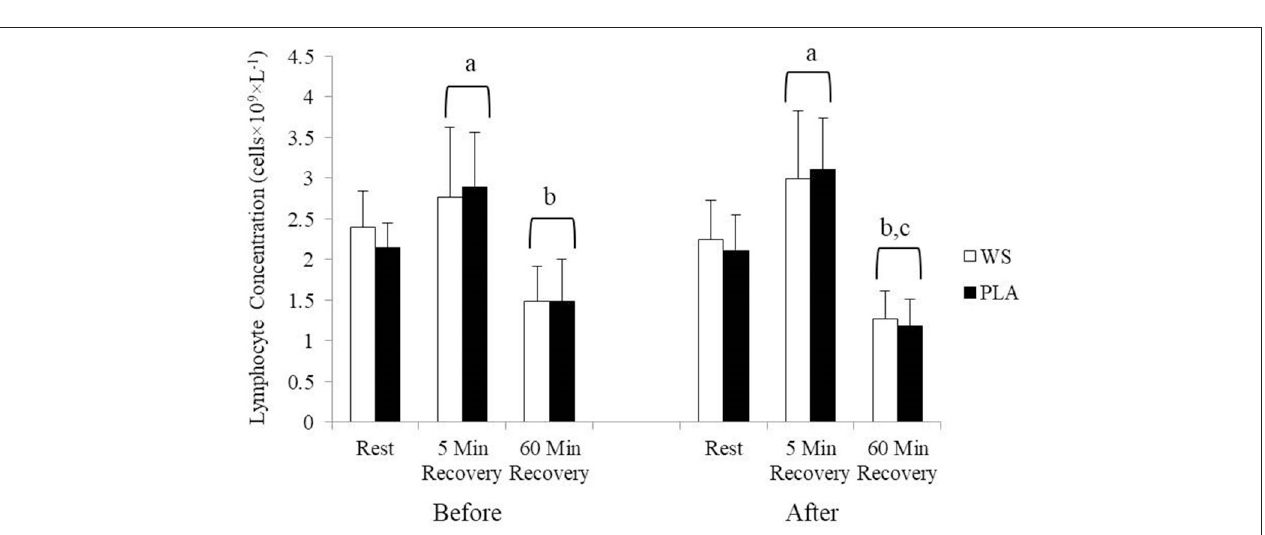
FIGURE 3 | Lymphocyte concentration at rest, 5 and 60min after exercise before and after training for the whey supplement (WS) and placebo (PLA) groups. Values are means ± SD. a, significantly different from rest, P < 0.05; b, significantly different from rest and 5min after exercise, P < 0.05; c, significantly lower at 60min of recovery after training, P <